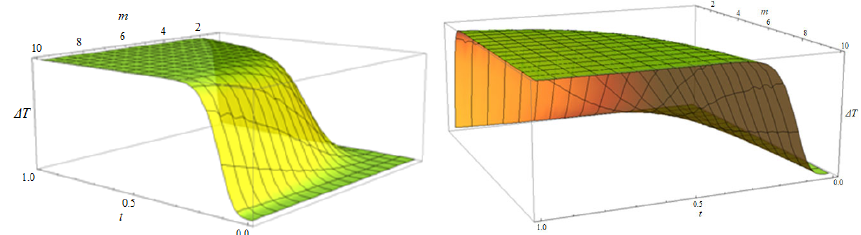
Table 1. The specific microscopic characteristics of the drug delivery systems. Sample Code